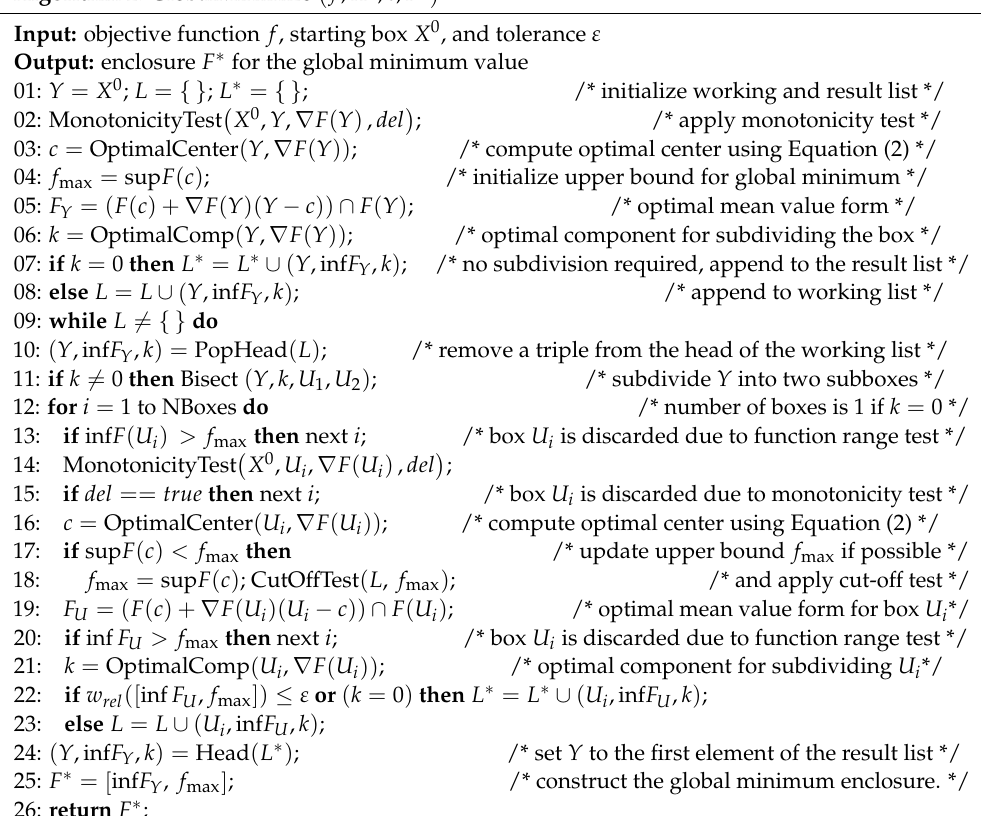
Algorithm 2 . GlobalMinimize